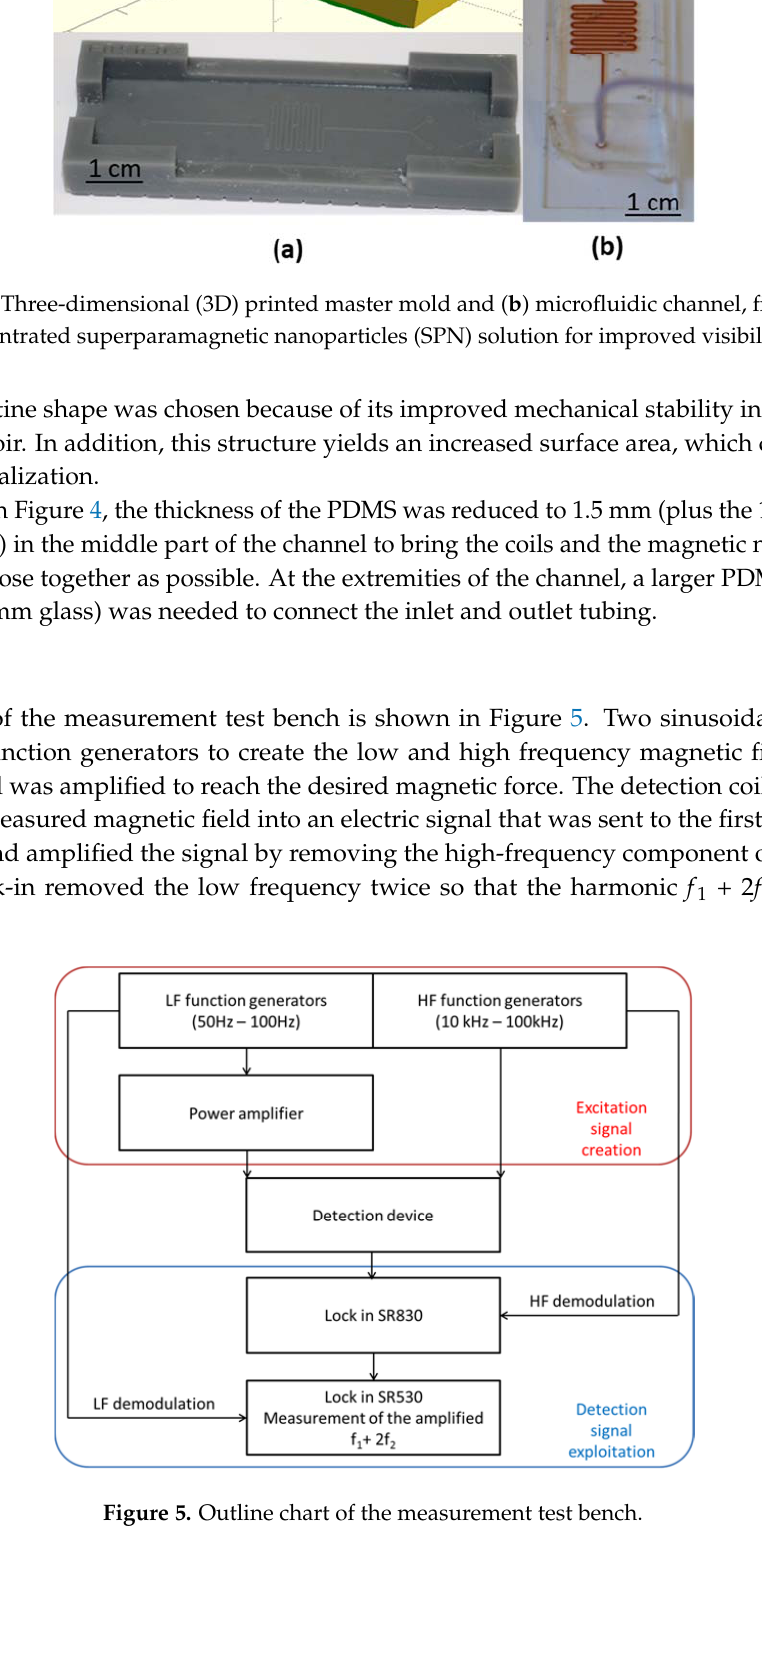
Figure 5. Outline chart of the measurement test bench.